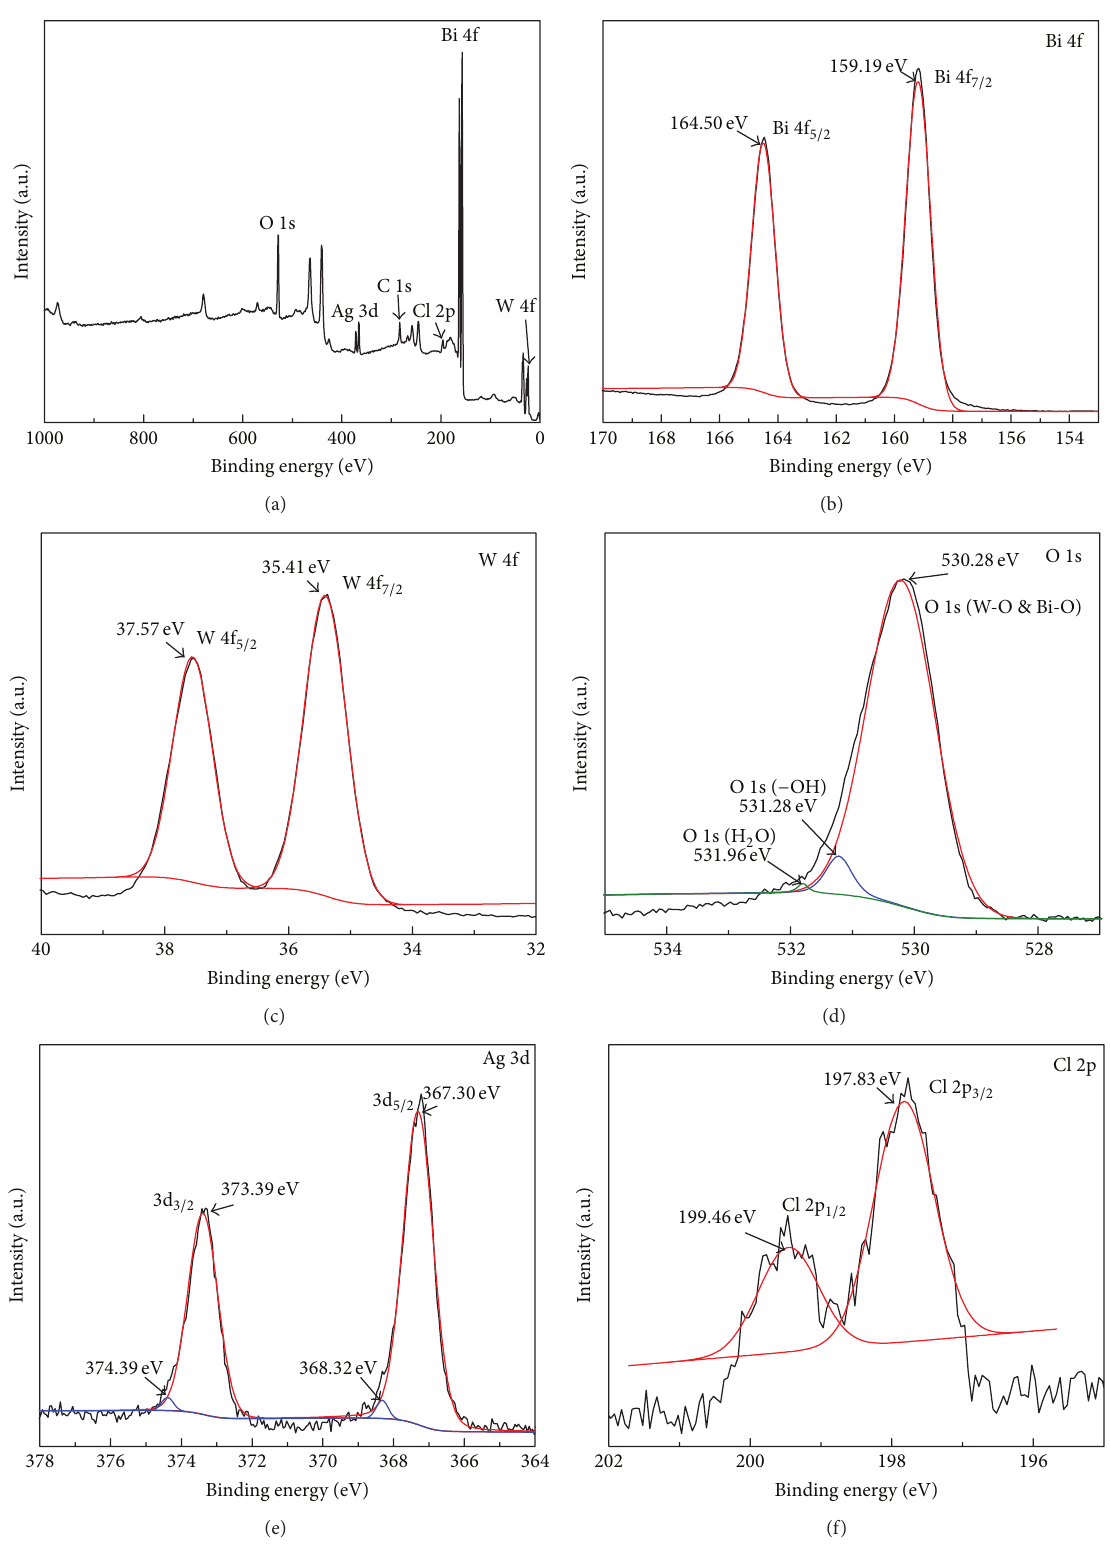
Figure 3: XPS spectra of Ag/AgCl (10wt%)-Bi 2 WO 6 composite: (a) survey spectra, and high-resolution orbits scan of (b) Bi 4f, (c) W 4f, (d) O 1s, (e) Ag 3d, and (f) Cl